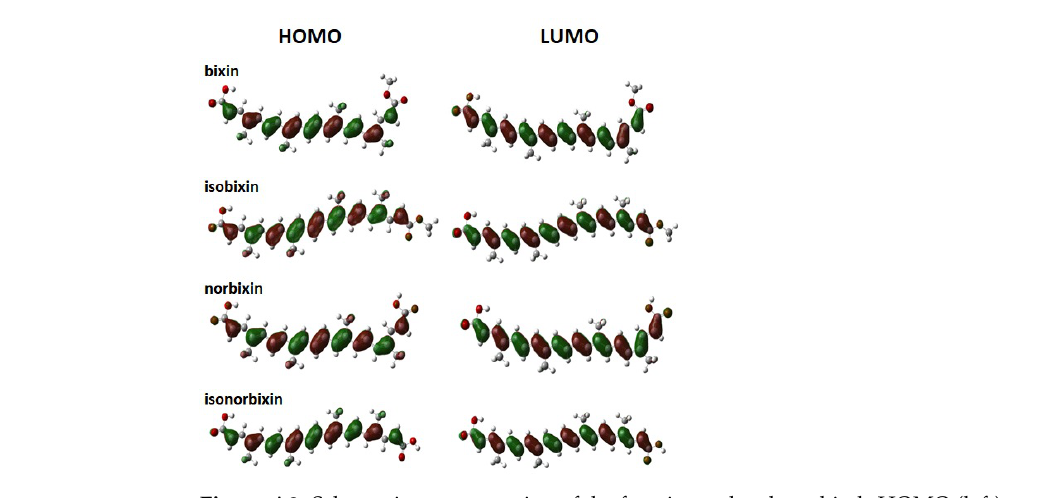
Figure A3. Schematic representation of the frontier molecular orbitals HOMO (left) and LUMO (right) of the molecular dyes in gas phase. These results were obtained by employing the CAM-B3LYP/6- 31+G(d,p) level of theory.